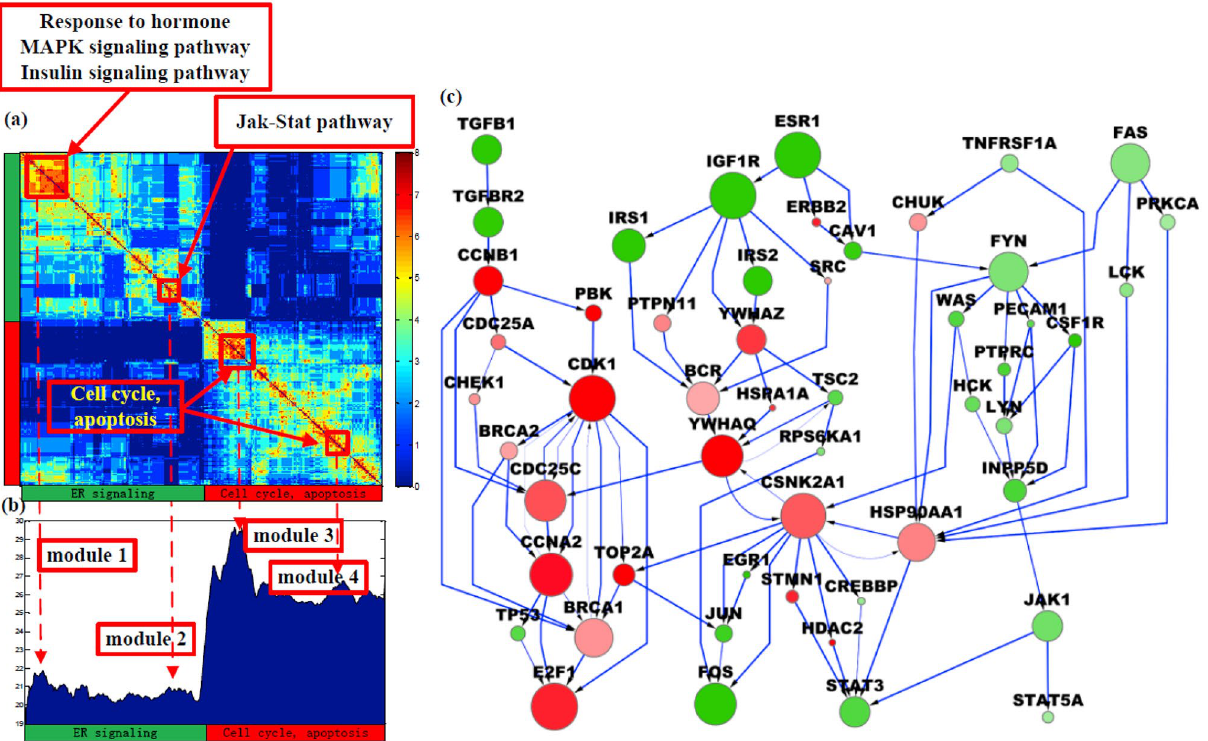
Figure 3. Pathway modules and crosstalk identified by IMPALA for the Loi dataset. ( a ) Pathway clustering based on gene similarity and gene functions in different clusters reveal the functional diversity of IMPALA- identified pathways. ( b ) Distribution of sampling frequency of pathways with peaks corresponding to major pathway clusters in ( a ). Four pathway modules were identified. ( c ) A combined pathway network consisting of the four modules with